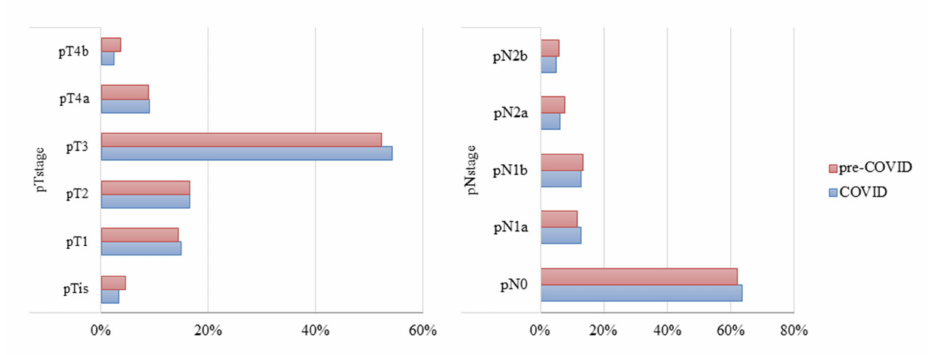
Figure 2. Pathologic TN stages of patients with colorectal cancer who did and did not receive chemotherapy during the pre-COVID and COVID